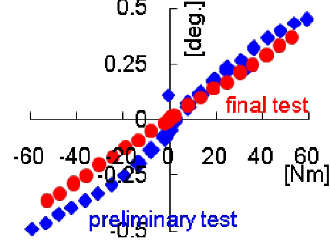
Figure 4. Stiffness test results for pitching